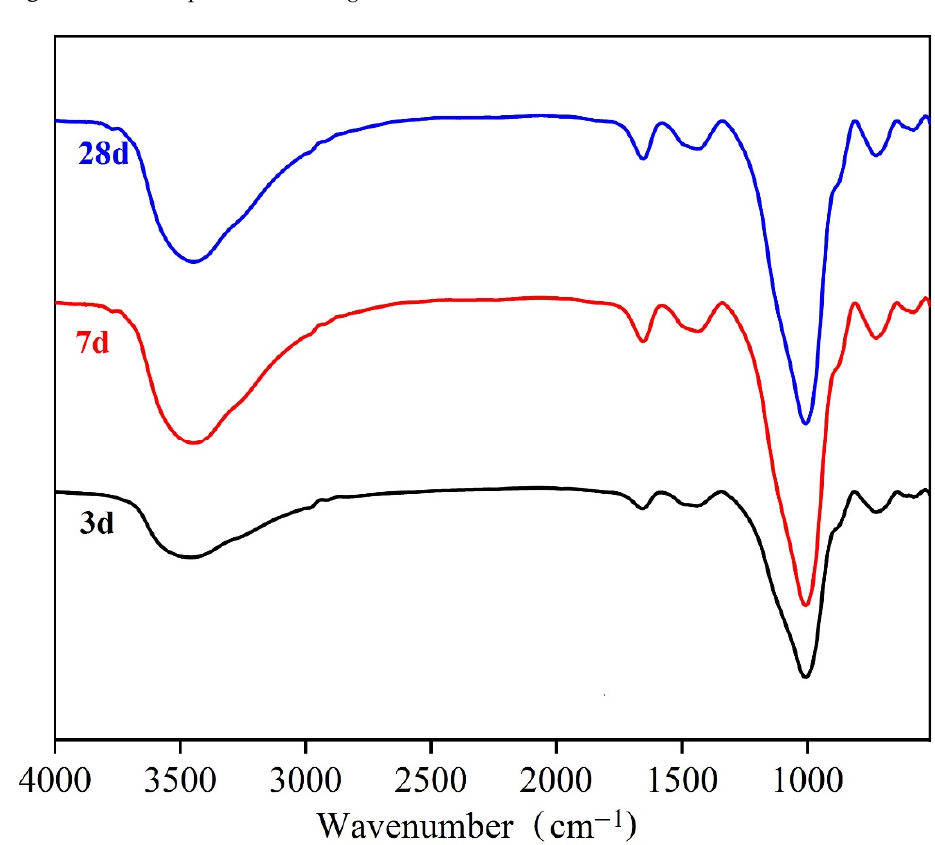
Figure 7. FT ‐ IR of paste with a range of curing periods. Figure 7. FT-IR of paste with a range of curing